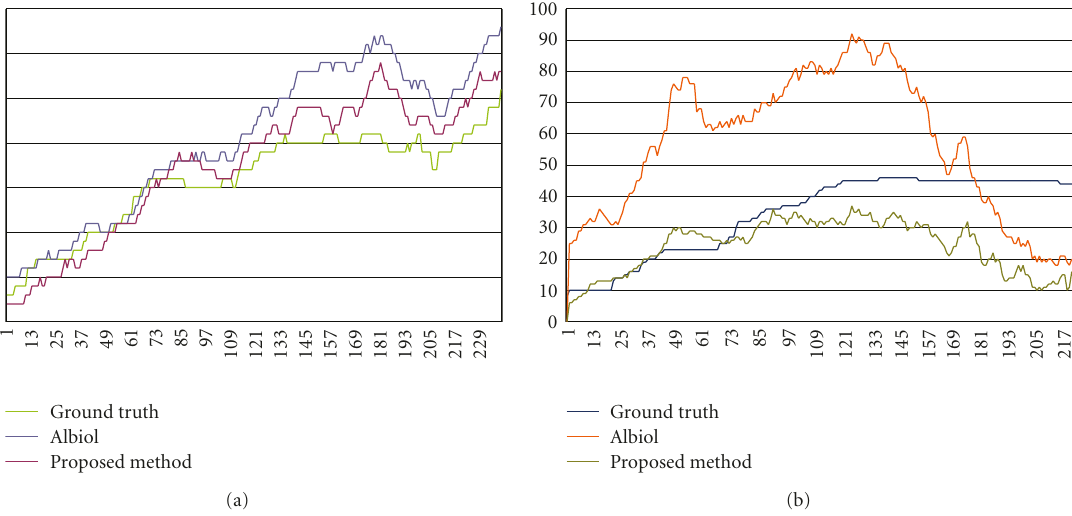
Figure 6: Curves of the number of people estimated by Albiol’s and our algorithms in each frame together with the ground truth on the video sequence S1.L1.13-59 view 1 (a) and S1.L1.13-57 view 2 (b). On the x -axis it is reported the frame